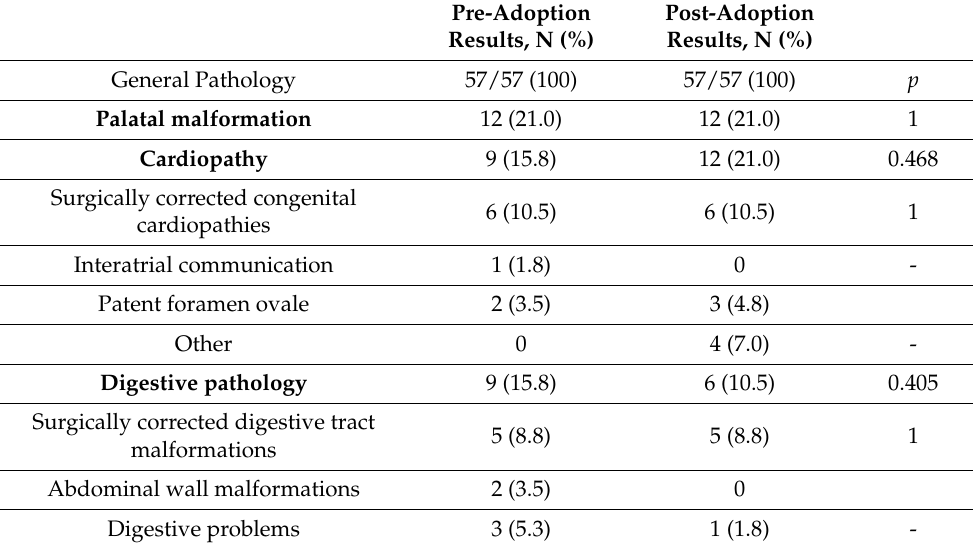
Table 1. Pre- and post-adoption results regarding pathologies reported in the respective medical